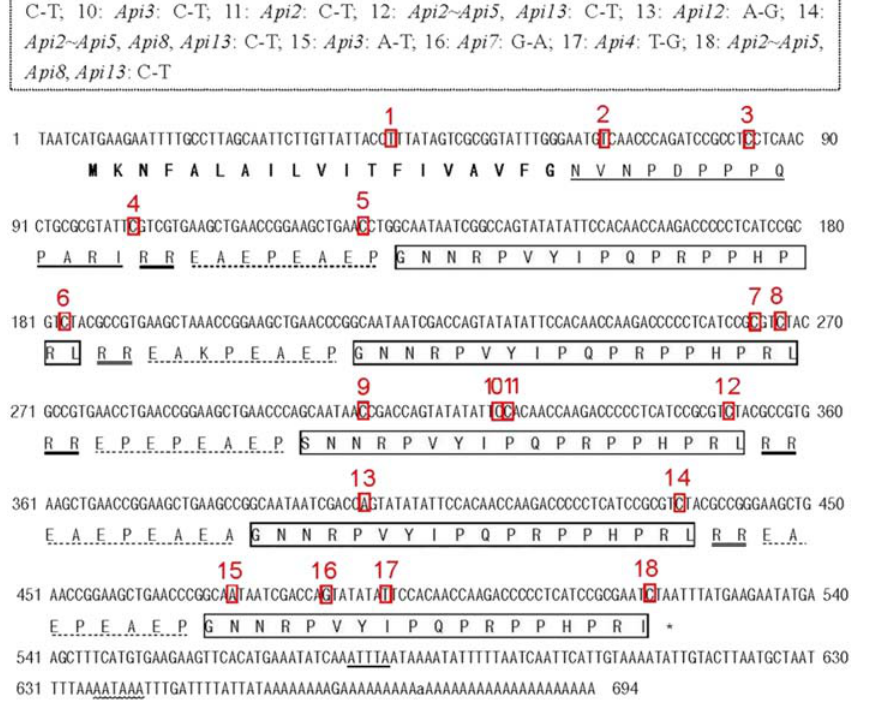
Figure 4. Nucleotide sequence and predicted amino acid sequence of Apidaecin1 (GenBank Accession EU727255). The putative signal peptide is bolded, the proregion of the peptide indicated by a single line, the dipeptide indicated by double line, the spacer sequences indicated by dotted line, the mature indicated by an open box, the translational signal (TAA) indicated by the star symbol, restriction and poly(A) adenylation signals(AATAAA) indicated by a wavy line, and the ATTTA sequence is indicated by a double wavy line. The variant loci are boxed in red or indicated by a short red arrow, and numbered in red. The nucleotide substitution sites in the precursor sequences between Apidaecin1 and other Apidaecin genes are boxed with a dotted line. ‘‘ Apidaecin1 , Apidaecin13 ’’ is abbreviated to ‘‘ Abi1 , Api13 ’’.